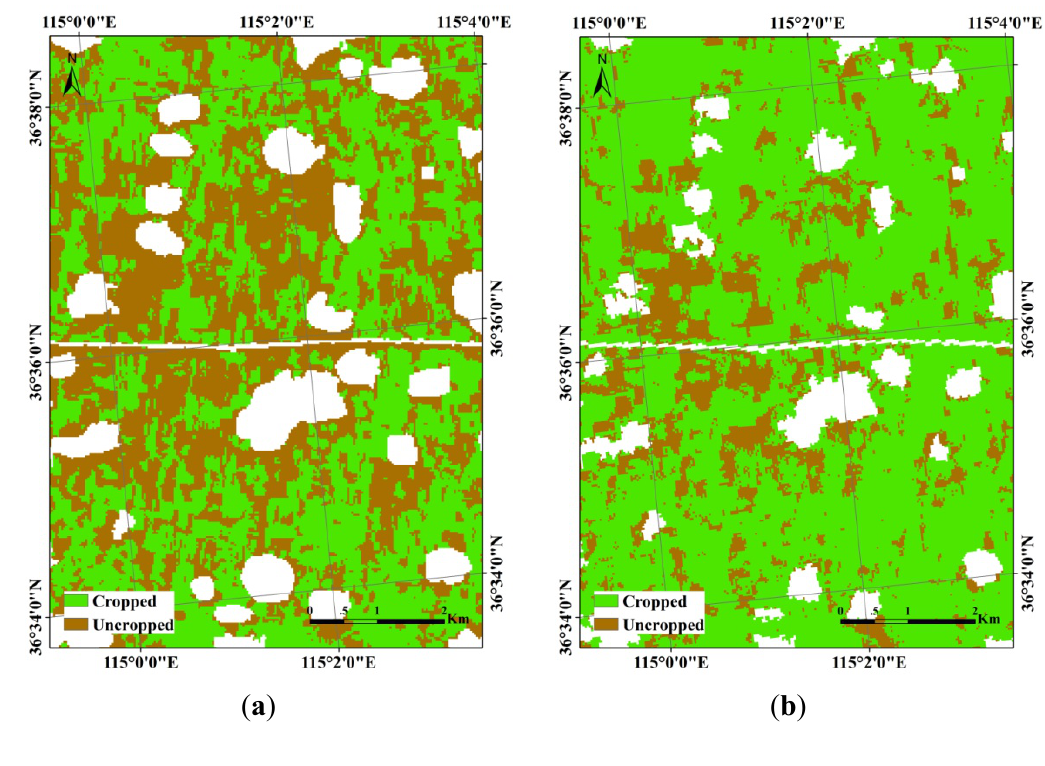
Figure 11. Crop monitoring using UALR-adjusted NDVI vs. MODIS NDVI. ( a ) Cropped and uncropped map in 2010; ( b ) cropped and uncropped map in 2011; ( c ) crop condition using MODIS NDVI; ( d ) crop condition using UALR-adjusted